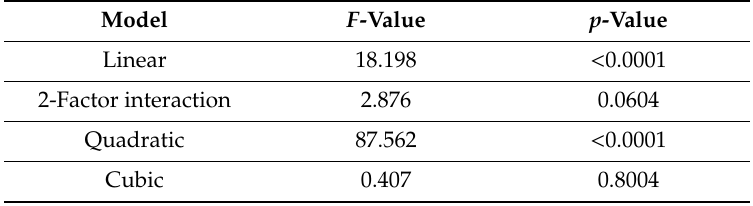
Table 2. Statistical parameters of the polynomial models.